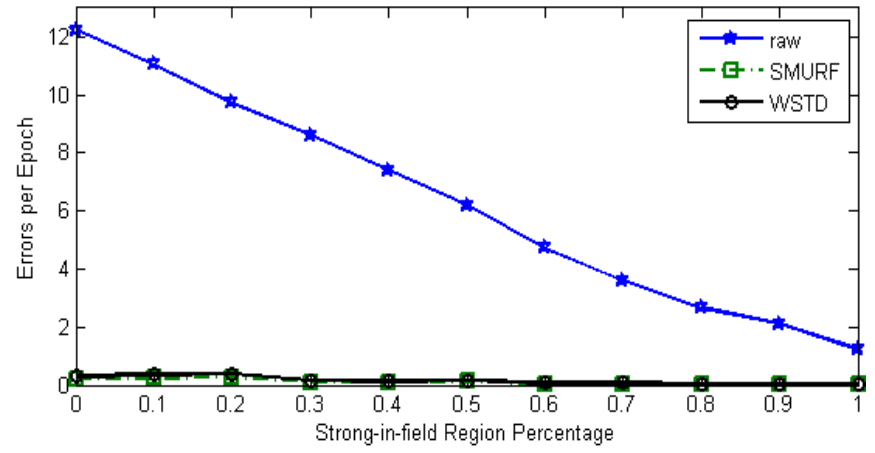
Figure 14. Average errors per epoch as strong-in-field region percentage is varied in the static tag